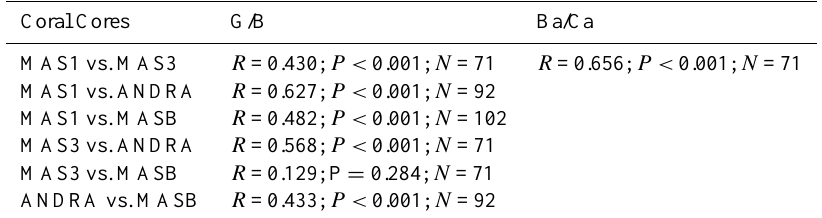
Table 1. Correlations of annual average G/B and Ba/Ca between coral records. Correlations are calculated using the maximum number ( N ) of years shared between corals. Individual G/B records are graphically shown in Fig.